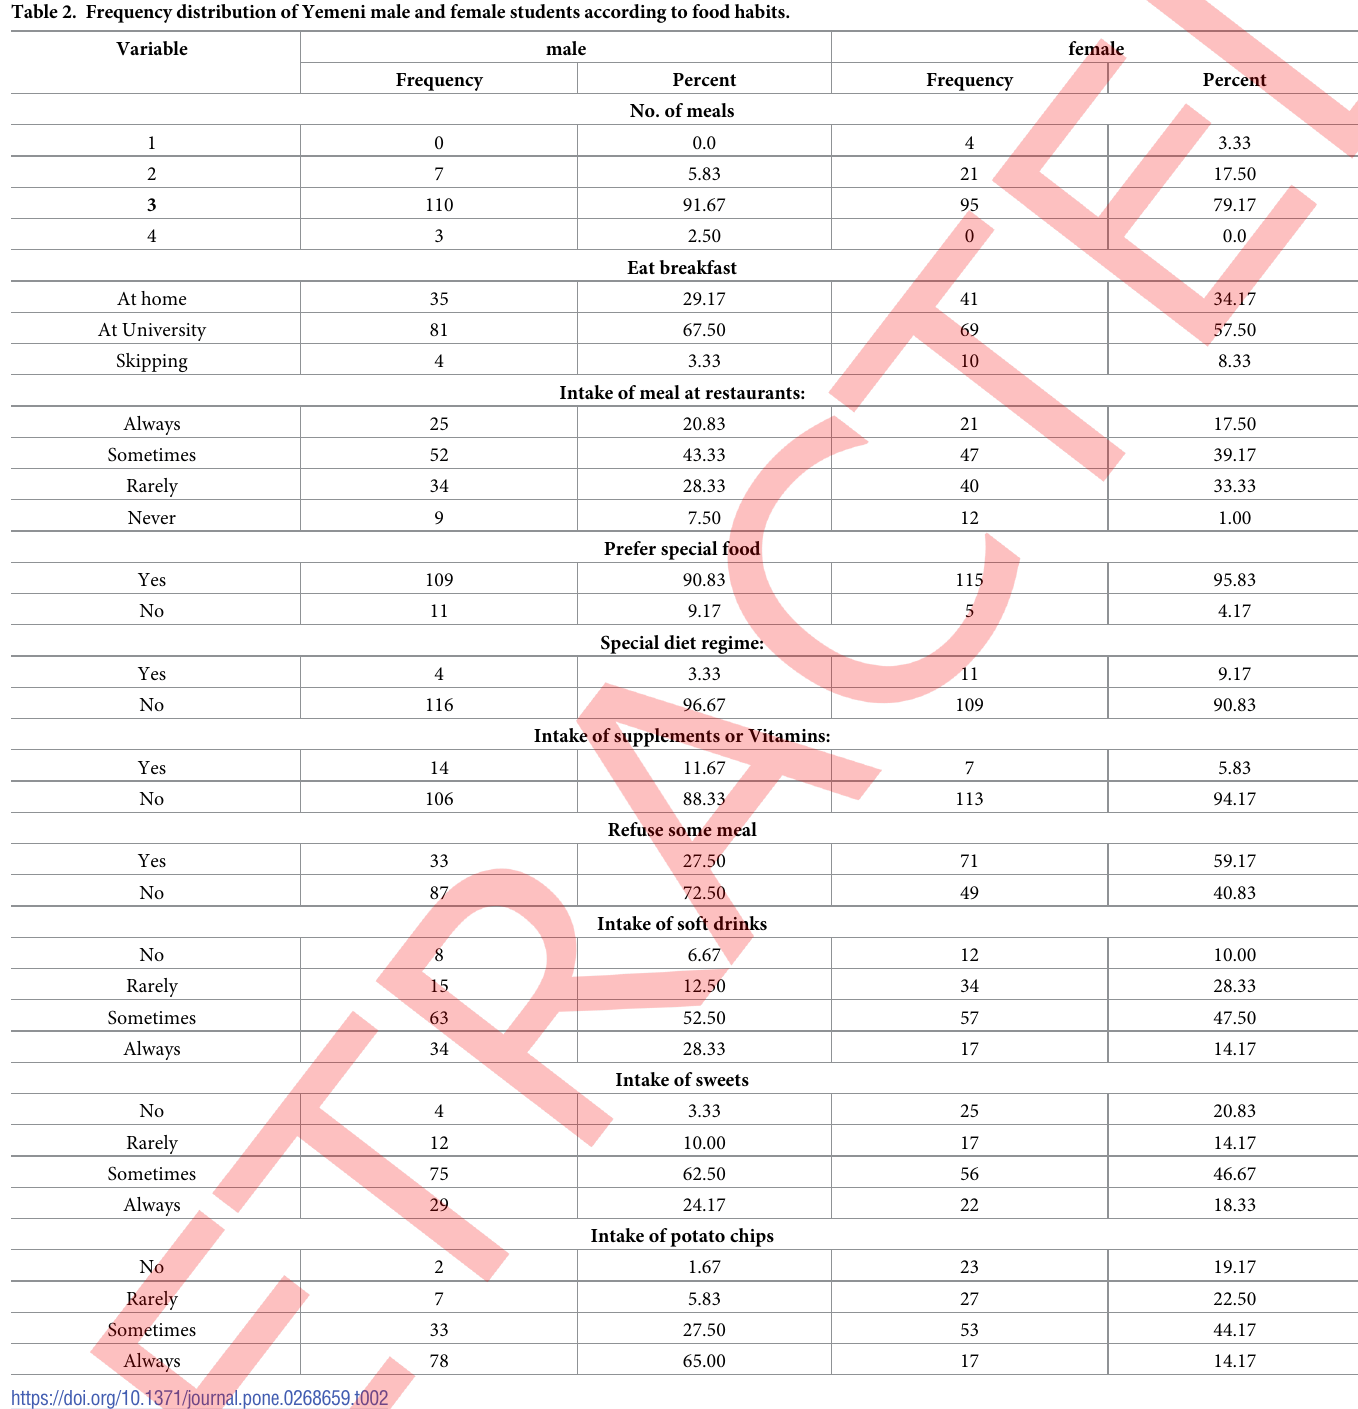
Table 2. Frequency distribution of Yemeni male and female students according to food habits.